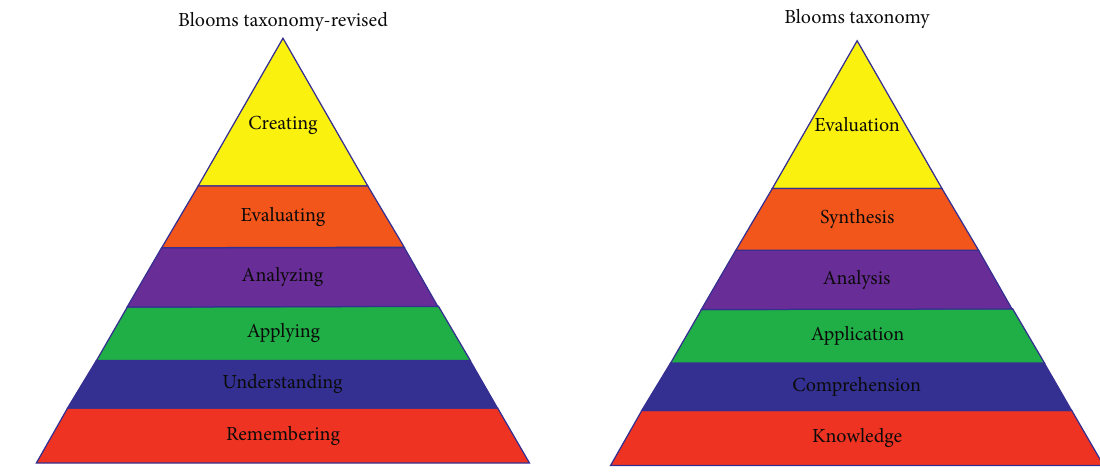
Figure 1: Bloom’s taxonomy: then and